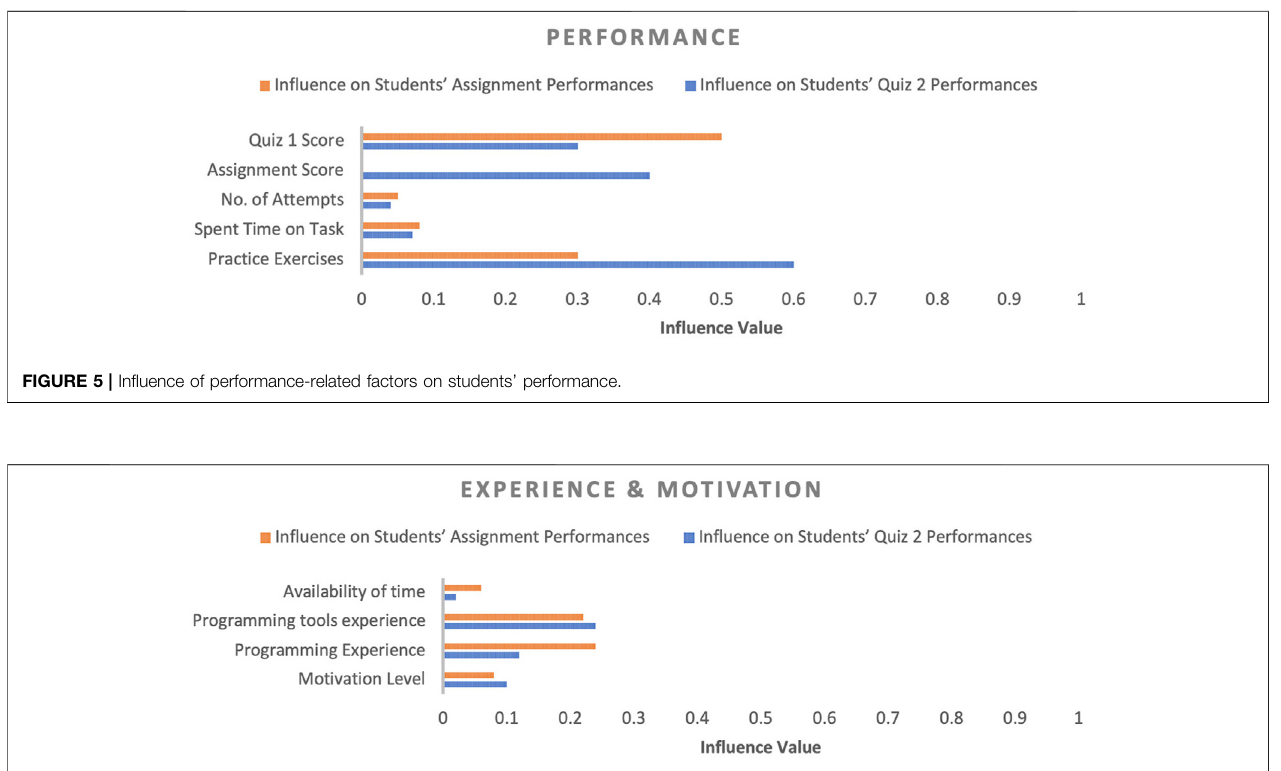
FIGURE 6 | In fl uence of experience- and motivation-related factors on students ’